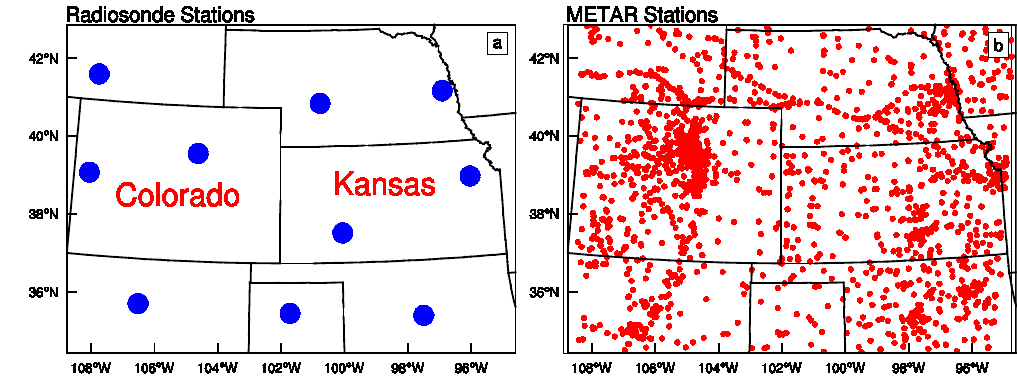
Figure 4. ( a ) The locations of 10 radiosondes (blue dots); and ( b ) 1927 METAR (red dots) stations over the inner region of domain.